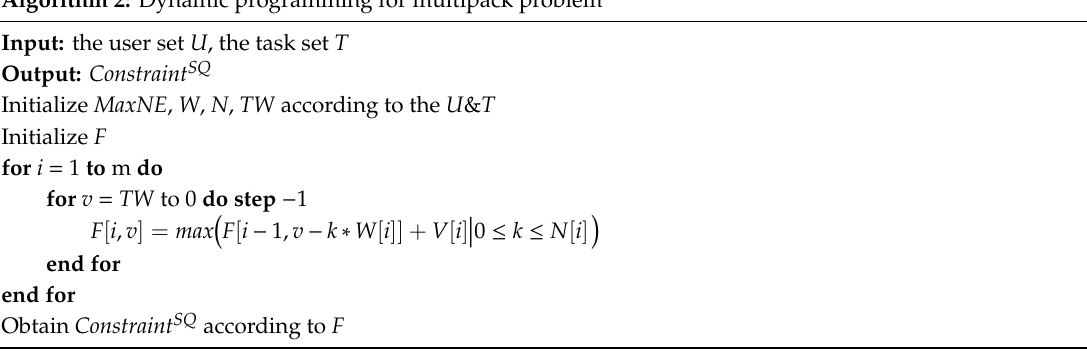
Algorithm 2: Dynamic programming for multipack